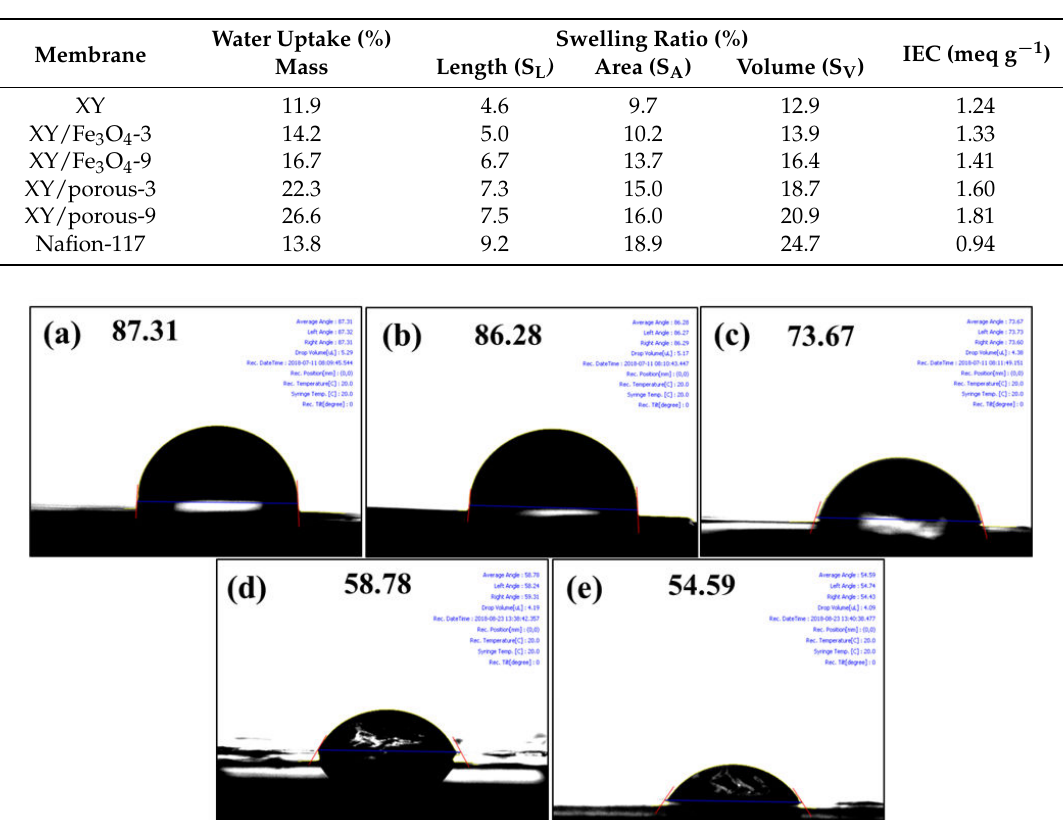
Table 2. Physiochemical properties of prepared membranes. IEC—ion exchange capacity.